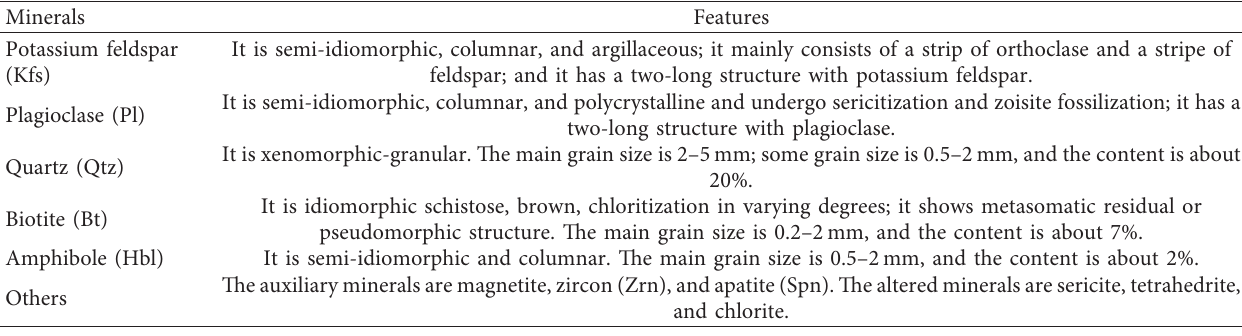
Figure 1: Sample and polarizing microscope images. (a) The sample surface, (b) plane-polarized light, and (c) cross-polarized light. Table 1: Mineral features according to polarizing microscope images.